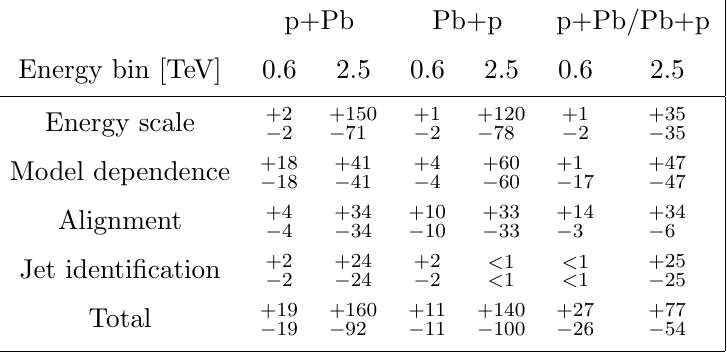
Table 1 . The contribution in percentage (%) of various sources of systematic uncertainty in the highest and lowest common energy bins for the p+Pb, Pb+p, and p+Pb/Pb+p